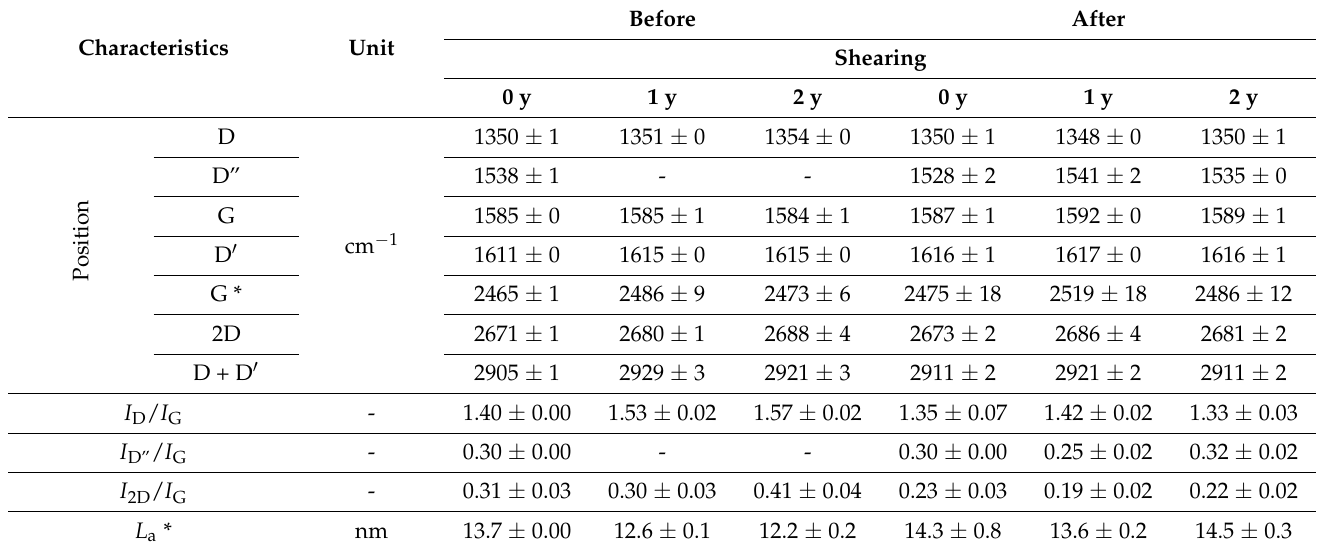
Table 5. Characteristic parameters deduced from the Raman